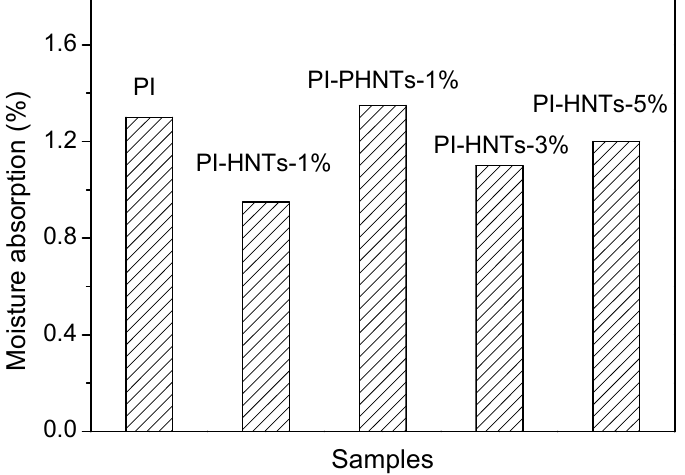
Figure 9. Moisture absorption of PI, PI-HNTs-1%, PI-PHNTs-1%, PI-HNTs-3%, and PI-HNTs-5%.